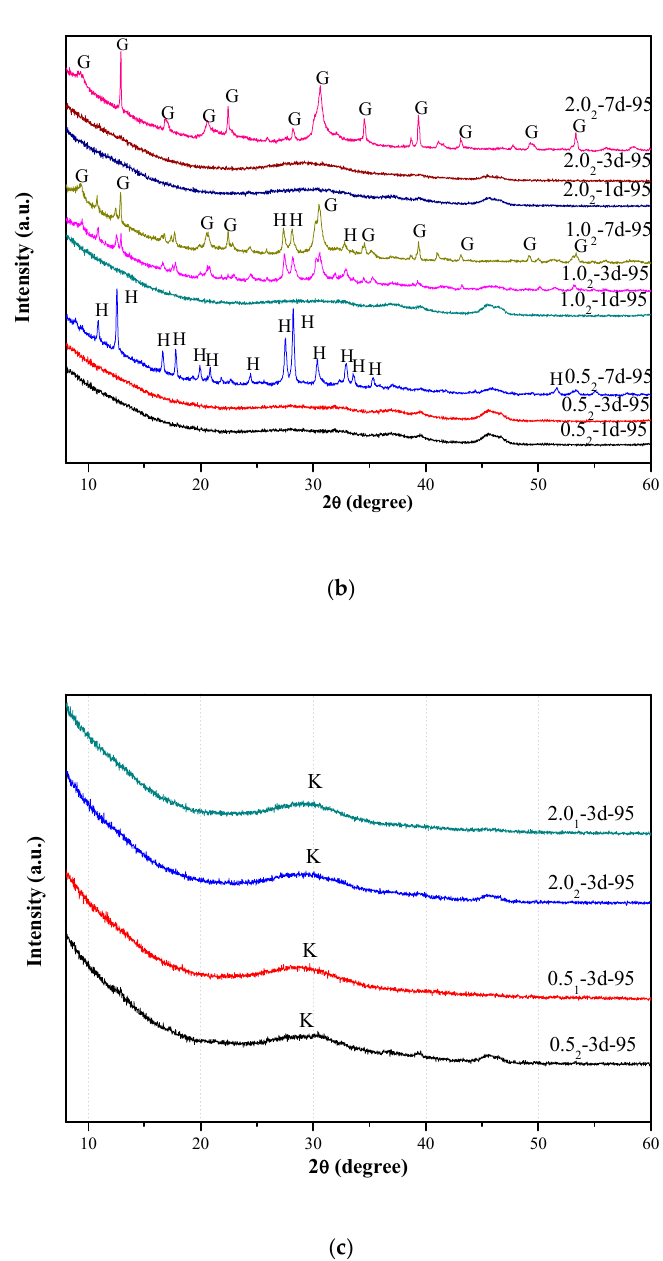
Figure 1. X-ray diffraction (XRD) patterns of K-A-S-H samples ( a ) synthesized at different reaction temperatures, ( b ) synthesized by reaction at 95 °C, and ( c ) synthesized using different SiO 2 /Al 2 O 3 ratios at 95 °C. (K: K-A-S-H gels, G: K-G zeolite, H: Zeolite